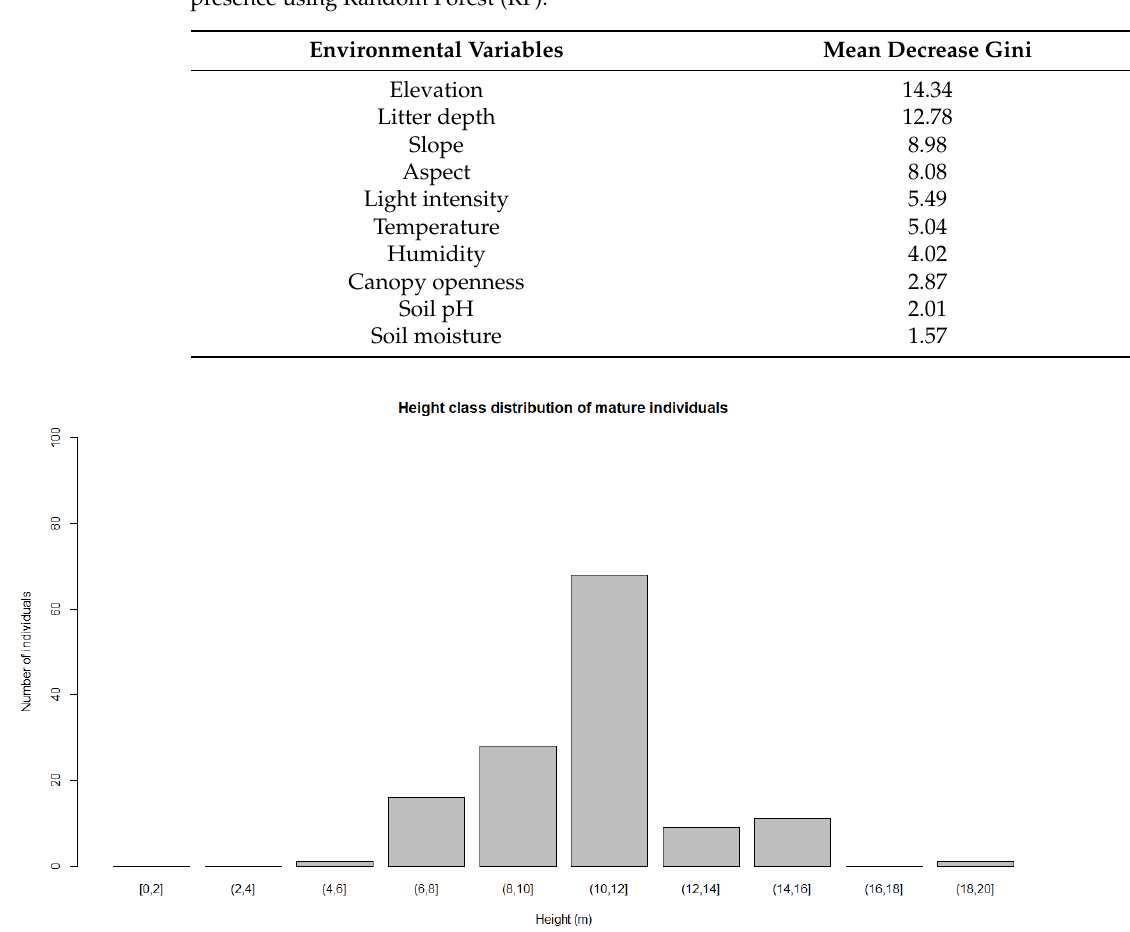
Figure 10. Height class distribution of juvenile individuals.